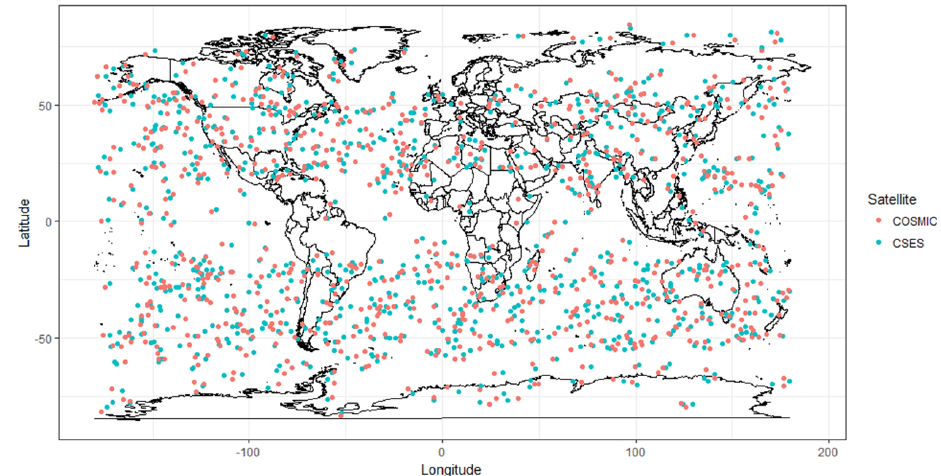
Figure 2. Distribution of the selected profile pairs. (Each dot indicates the location of the tangent point of the maximum values in a profile.)